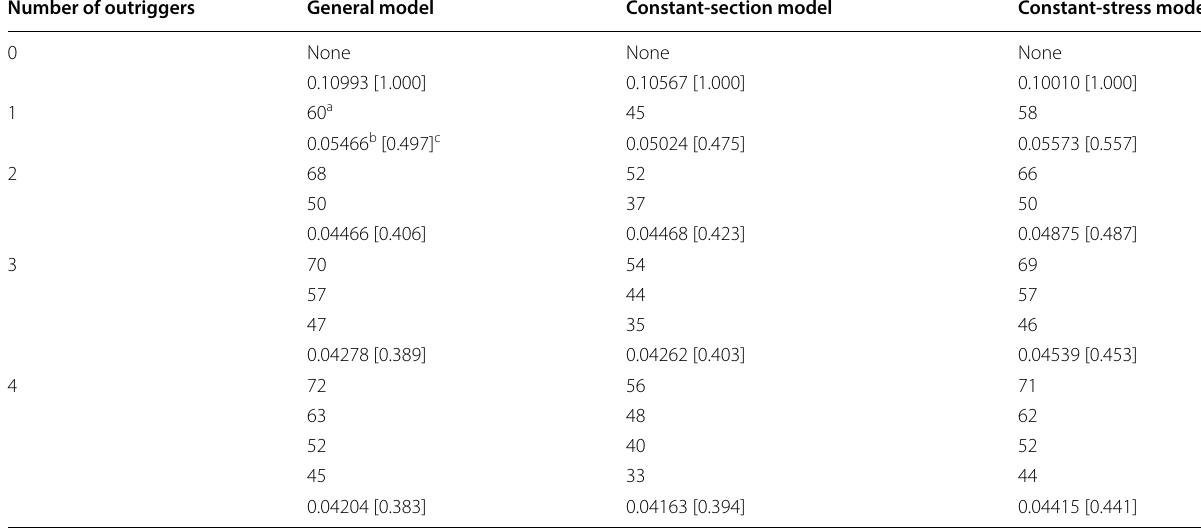
Table 2 Optimum locations and maximum DAS with the divided-area